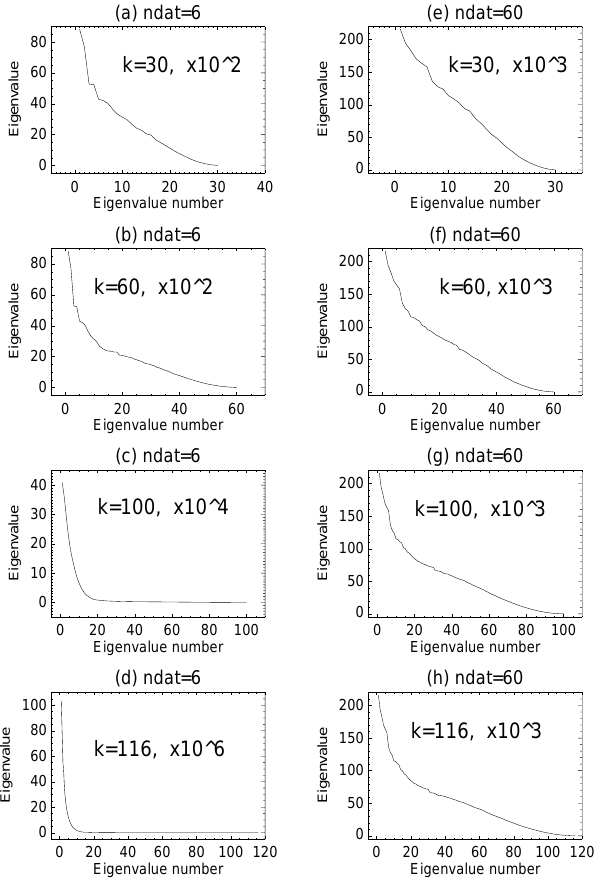
Fig. 1. The eigenvalue distribution: (a) ndat = 6, K = 30, (b) ndat = 6, K = 60 , (c) ndat = 6, K = 100, (d) ndat = 6, K = 116, (e) ndat = 60, K = 30, (f) ndat = 60, K = 60, (g) ndat = 60, K = 100, and (h) ndat = 60, K = 116.